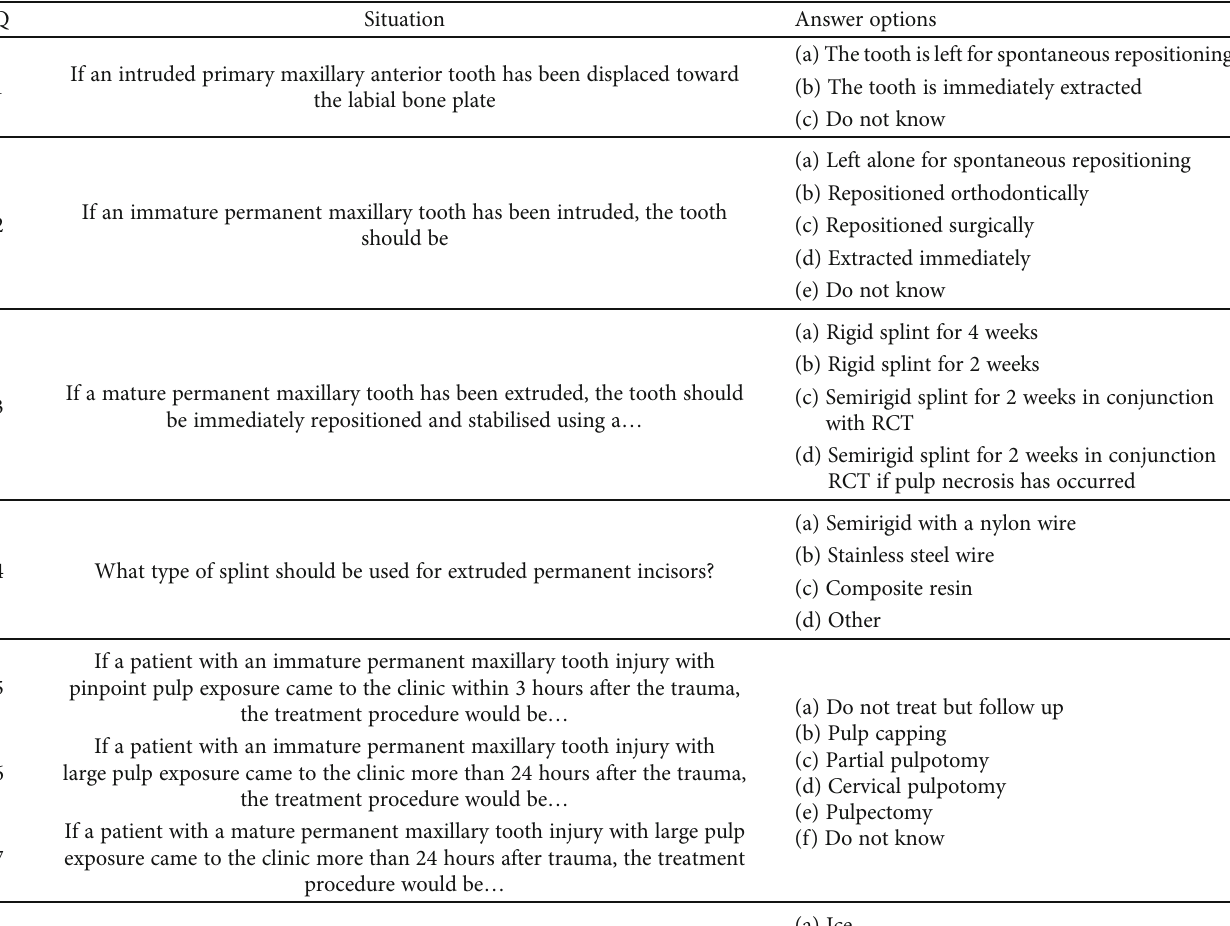
Table 1: Questions related to knowledge of emergency management of